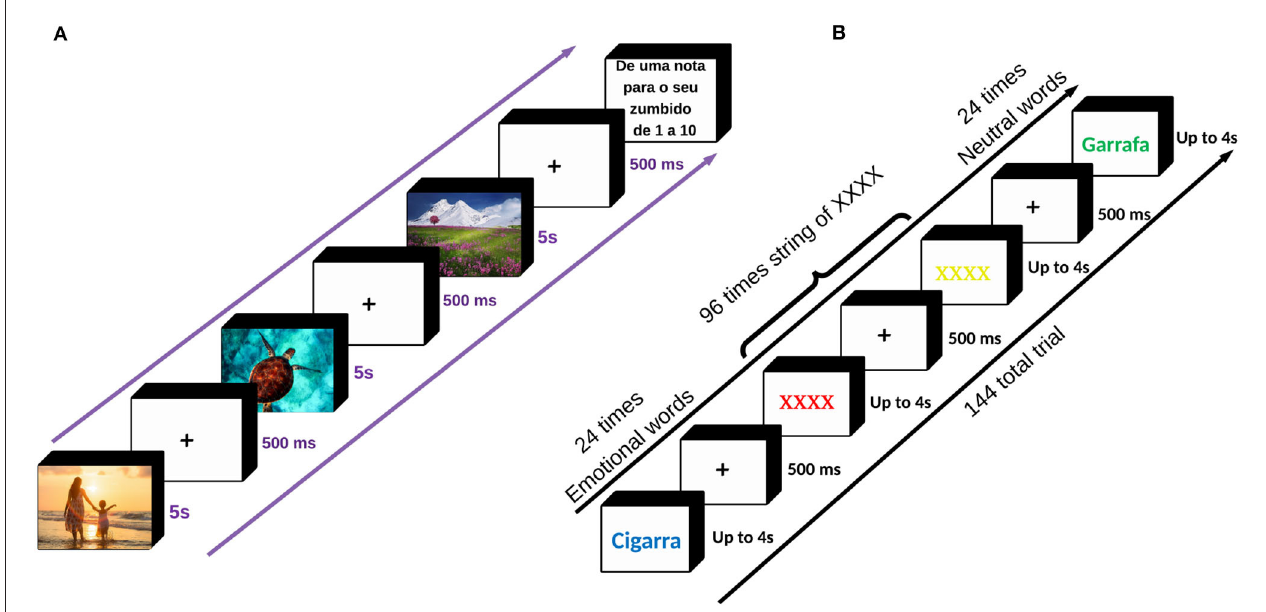
FIGURE 4 | (A) The sequence of picture presentation. During the experiment, 80 neutral pictures and two-hundred positive pictures were displayed. Each picture was presented for 5 s with a cue of 500 ms in between. The positive emotion induction was concurrent with anodal stimulation, sham stimulation, or without any stimulation. Throughout the picture presentation, every 2 min we asked TLQ “Scale your tinnitus loudness from 1 to 10,” to keep the patients consciously attended to the perception of their tinnitus. The total time duration of the picture presentation was almost 28 min . (B) The sequence of trials in EST. In this task, six neutral and six emotional words, as well as the XXXX string (coming for two consecutive times after each word presentation), were randomly colored in red, blue, yellow, and green producing a total of 24 times for neutral and 24 times for emotional words as well as 96 times the XXXX string presentation, collectively 144 trials. The Patients were instructed to ignore the meaning of the stimuli and just respond to the colors seen by pressing one of the four corresponding keys: Z, X, N, M representing green, yellow, blue, and red, respectively, already programmed and colored on a LED keyboard. Before starting the task, the patients received a 10-s instruction explaining how to adjust their fingers over the four corresponding keys and how to act during the task. Either of the words or the XXXX string was presented for up to 4 s with a cue of 500 ms in between, lasting 10 min in total. EST was taken twice before and after the main intervention. List of words used in the Emotional Stroop Task. The patients were asked to list-out a set of words describing their tinnitus sound and rate either of the words from 1 (least annoying) to 5 (most annoying) to show how annoying it is. Six words with the highest frequency and annoyance were selected and matched with six neutral words in terms of syllables, word length, and frequency of use within the Portuguese language. "Neutral Wordlist": {Garrafa, Banheiro, Luz, Antigo, Milho, and Patio}, and "Emotional Wordlist": {Cigarra, Campainha, Tom, Apito, Grilo, and Radio} Source: Adapted from the Andersson et al. (2000;